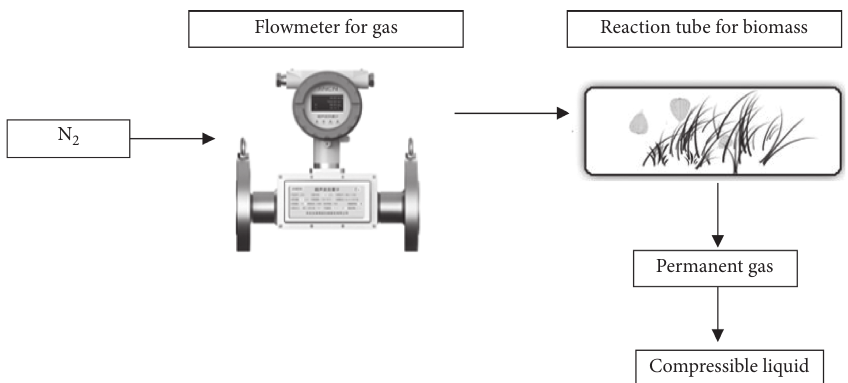
Figure 4: Schematic process of the torrefaction process.